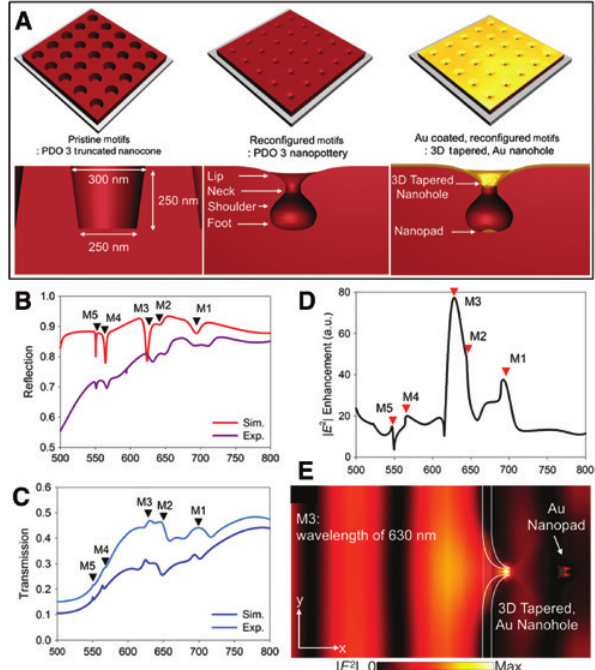
Figure 21: Light nano-focusing through the reconfigured array of nano-holes covered by a thin metallic